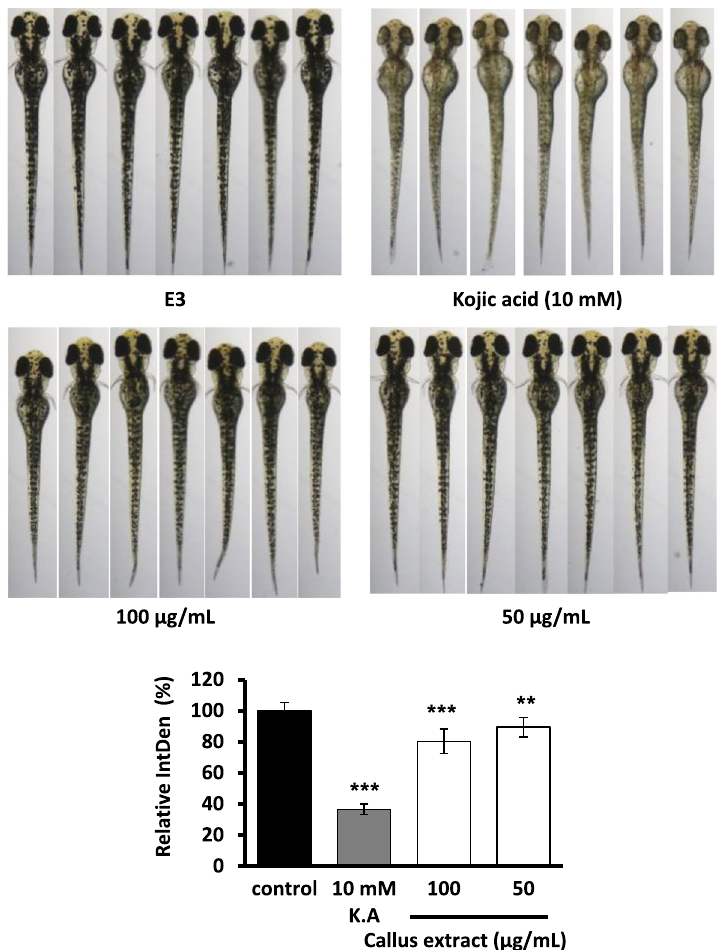
Fig. 7 The pigmentation inhibition effect of B. formosana callus extract in zebrafish model. The data are expressed as percentage of pigment formation. The results are expressed as means SD. # p < 0.05, ## p < 0.01, and ### p < 0.001 compare with ±